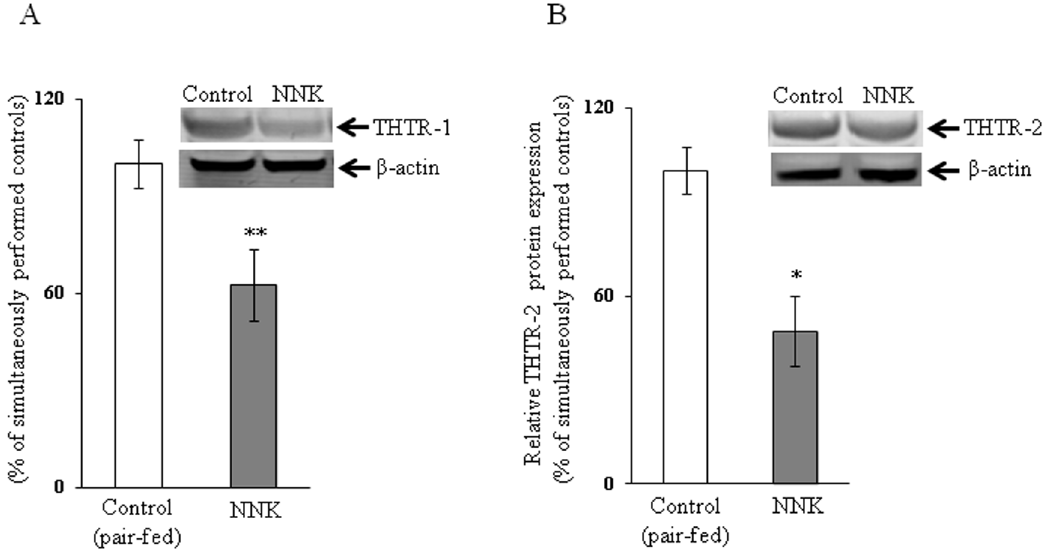
Figure 6. Effect of chronic exposure of mice to NNK on the level of expression of THTR-1 and THTR-2 proteins in primary pancreatic acinar cells. Western blot analysis was done using pancreatic acinar whole cell proteins (60 m g) isolated from chronic NNK exposed mice and their pair-fed controls. A and B: blots were incubated with goat polyclonal THTR-1 and THTR-2 antibody respectively. Data are mean 6 SE of at least 3 independent experiments and were normalized relative to b -actin protein expression. * P , 0.01, ** P , 0.05.